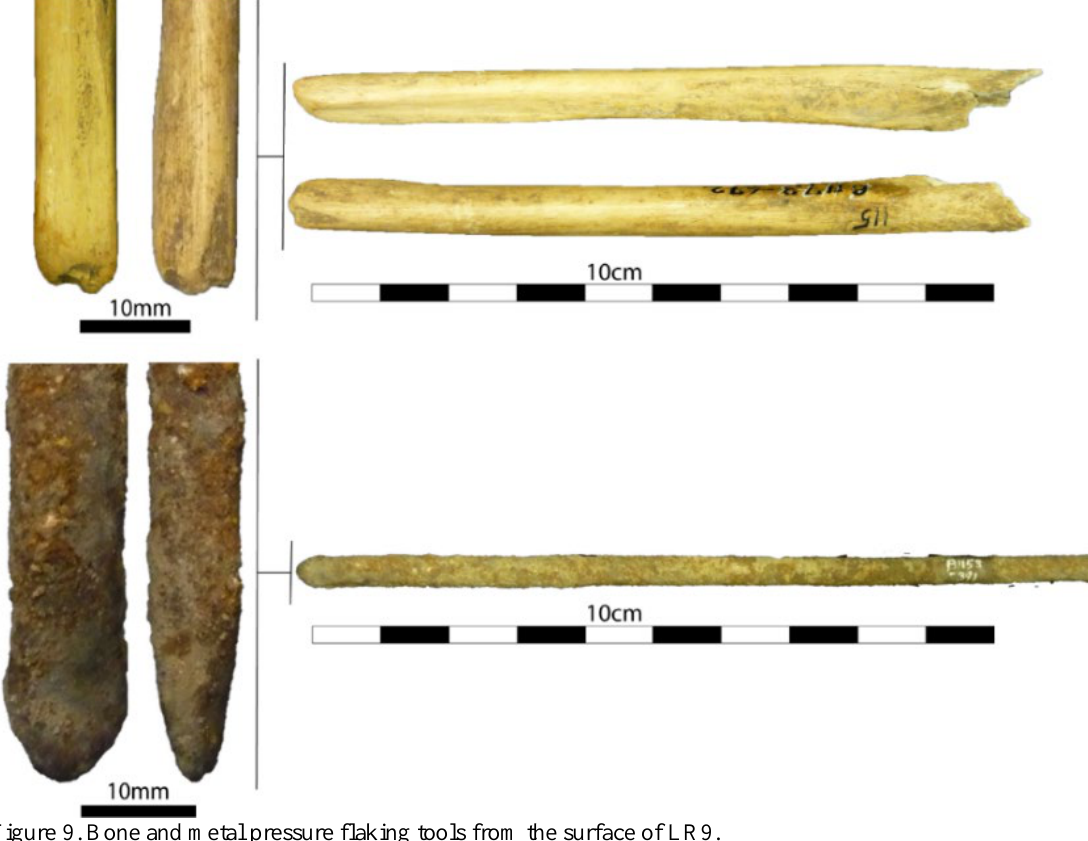
Figure 9. Bone and metal pressure flaking tools from the surface of LR9.